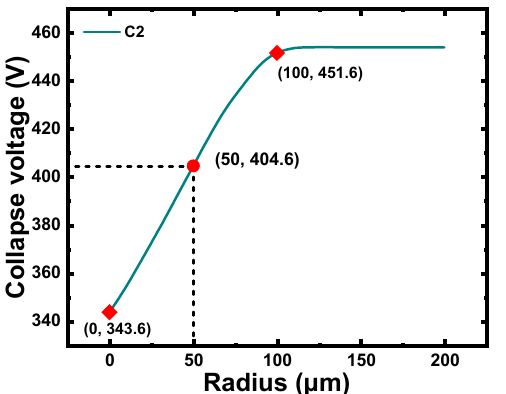
Figure 8. Collapse voltage of C2 with different values of bottom radius of cavity under pressure of 10 kPa (0 μm ≤ 𝑟 (cid:2913) ≤ 200 μm ).